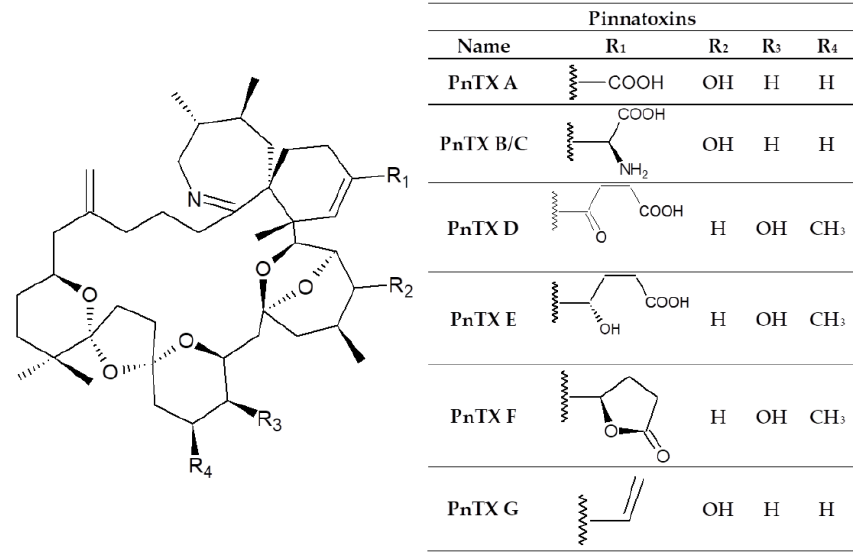
Figure 1. Chemical structure of pinnatoxins.